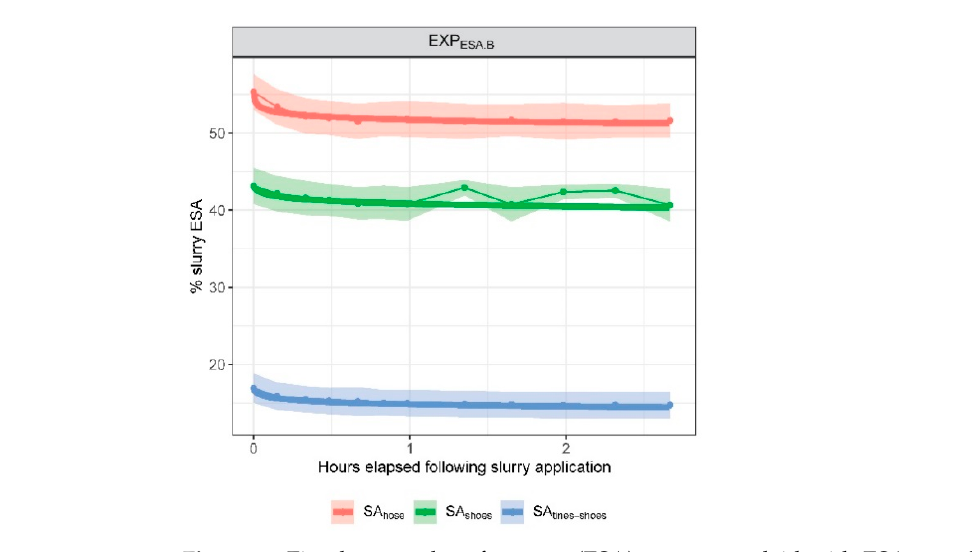
Figure 1. Fitted exposed surface area (ESA) curves overlaid with ESA raw data following field application of 30 tonne ha − 1 pig slurry to a winter wheat crop on sandy loam soil (EXP ESA.B ). Standard errors for raw data are displayed in bands.